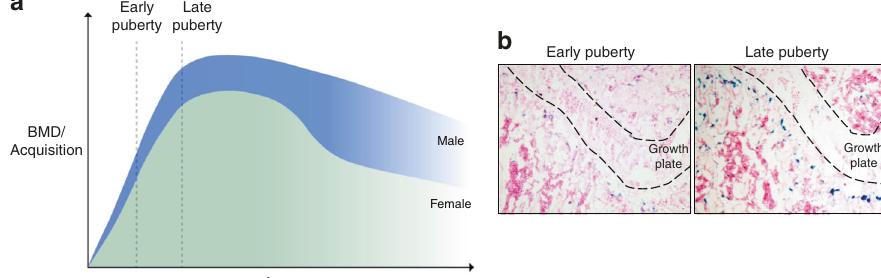
Fig. 2 Cell senescence in long bone during late puberty is a programmed physiological process. a Changes in bone mineral density (BMD)/ bone acquisition across the lifespan. BMD/acquisition increases rapidly during childhood and early puberty periods, becomes slow during late puberty, and reaches a plateau in young adulthood. b SA- β Gal staining images show increased senescent cells in primary spongiosa in mice during late puberty (8 weeks old) relative to early puberty (3 weeks